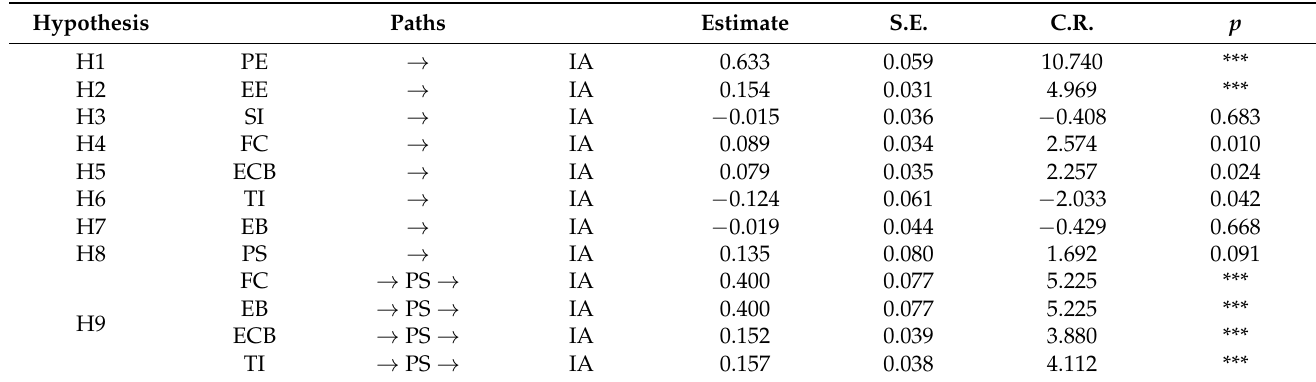
Table 2. Path relationships of the study findings.